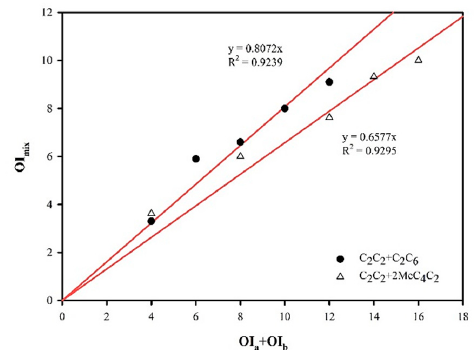
Figure 2. The relationship between OImix of a binary odor mixture (OIa+OIb) and the summation of its unmixed constituents’ odor intensities (OIa+OIb).